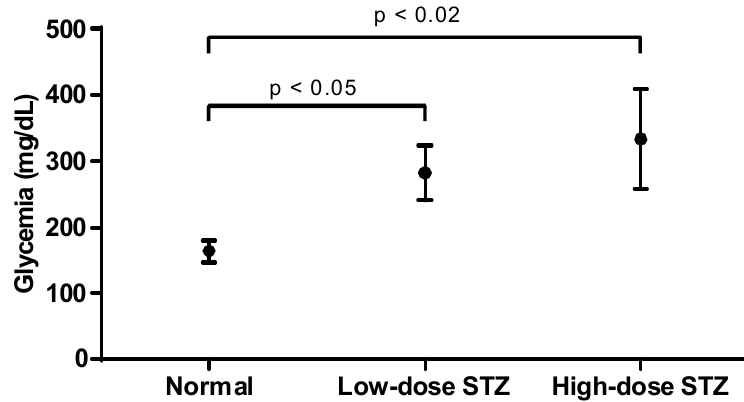
Figure 1. Effect of streptozotocin in mice glucose levels. Mean values (± standard deviation) of glucose levels (mg/dL) measured in normal and diabetic mice ( n = 6) over a period of 5 months. Two different groups of diabetic mice are presented, the low-dose STZ and the high-dose STZ. Higher doses of streptozotocin yielded higher levels of glycemia.